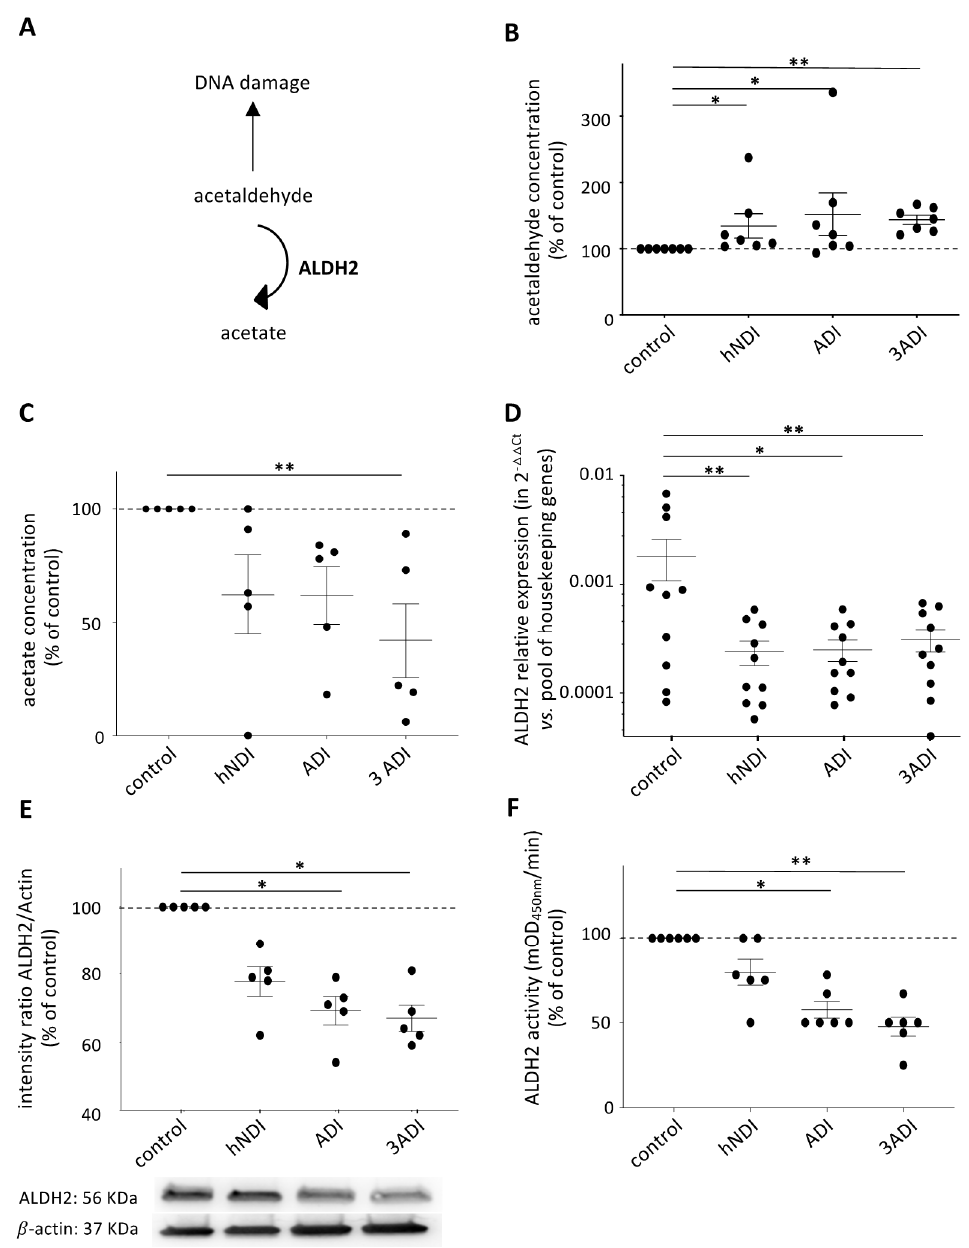
Figure 3. Mitochondrial acetaldehyde catabolism is altered after 21 days of exposure to pesticides. ( A ) Schematic representation of mitochondrial acetaldehyde catabolism via the ALDH2 enzyme. ( B ) Acetaldehyde (ALDH2 substrate) quantified by spectroscopy, is increased in exposed BM-MSCs ( n = 7), and, concomitantly, ( C ) acetate concentration (ALDH2 product), is decreased in these cells ( n = 5), indicating abnormal catabolism of acetaldehyde to acetate. ( D ) The analysis of ALDH2 relative expression indicates a strong decreased of ALDH2 mRNA abundance in case of exposure to pesticides ( n = 10). ( E ) ALDH2 protein quantification by western blot also reveals a decreased ALDH2 production ( n = 6). ( F ) Finally, ALDH2 enzymatic activity, quantified by spectroscopy, is decreased in BM-MSCs exposed to pesticides ( n = 6). Data are expressed as percent of the control ± SEM; *, p < 0.05; **, p < 0.01; Friedman or Kruskall–Wallis followed by post hoc multiple comparisons test. The uncropped western blot images can be found in Figure S4.